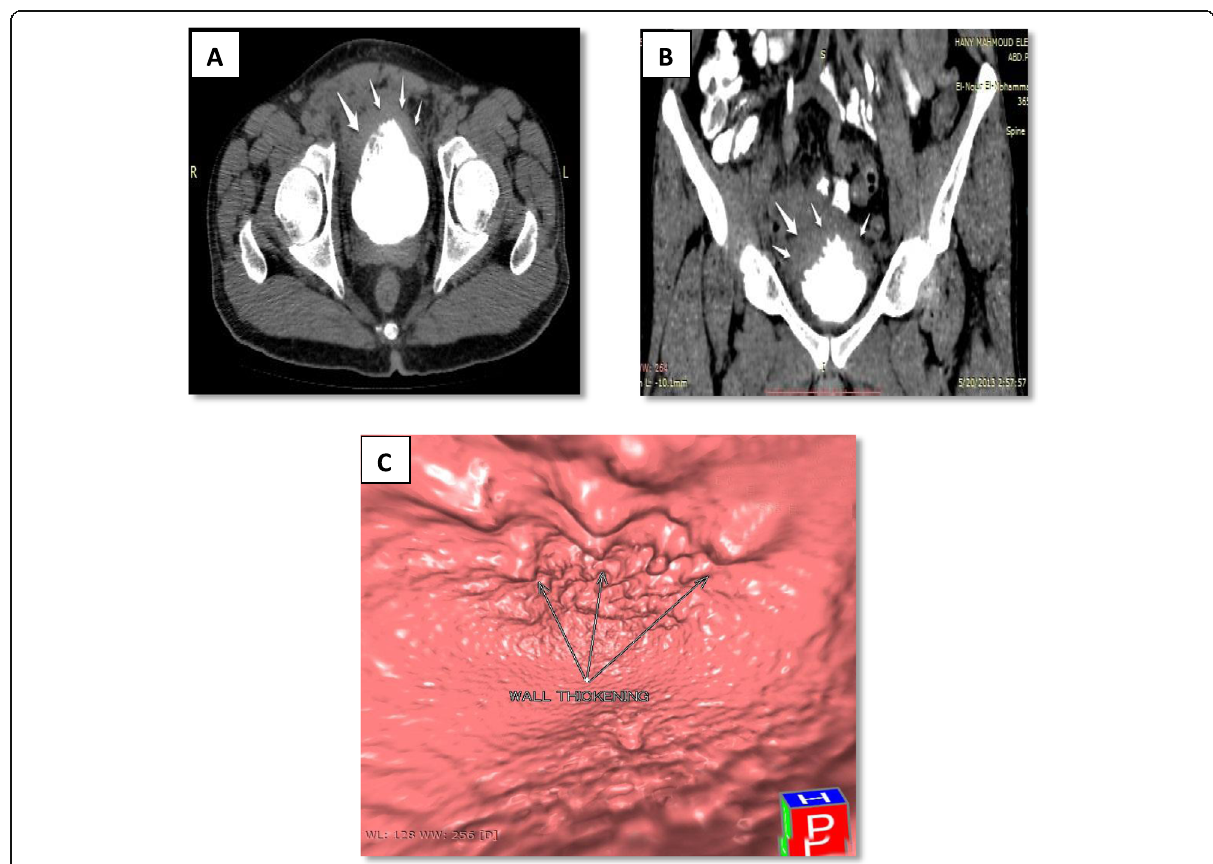
Fig. 3 a , b Male patient 48 years old presented with hematuria. Contrast-enhanced CT with axial ( a ) and coronal ( b ) images showed urinary bladder infiltrative soft tissue lesion involving the anterosuperior wall with marked irregular focal thickening and further extension to the anterosuperior perivesical fat (arrows), no enlarged lymph nodes nor distant metastases could be detected. c VC image shows clearly the wall thickening and the mucosal irregularities (arrowed). Biopsy was taken and revealed high grade transitional cell